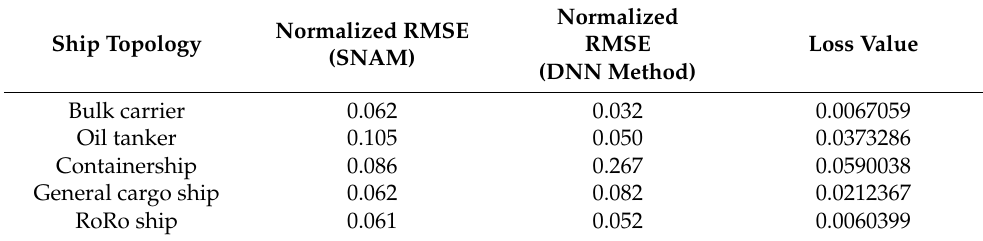
Table 5. Normalized RMSEs for the SNAM and the DNN method and the associated loss